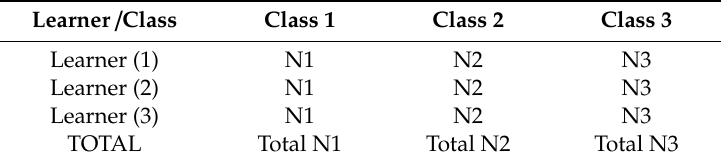
Table 3. Learners’ participations